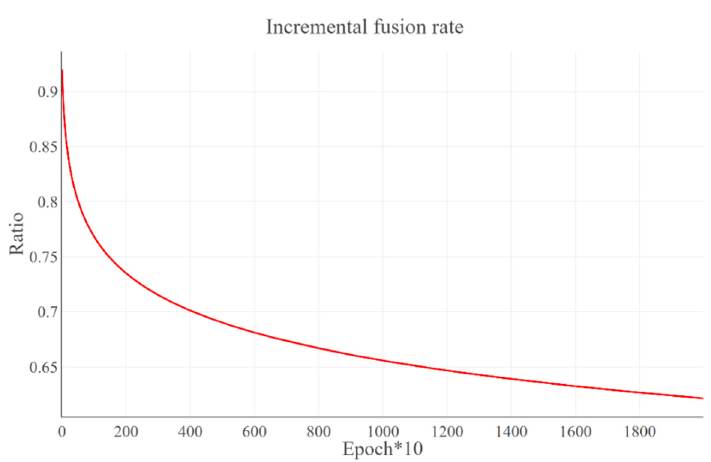
Figure 3. The curve of the incremental fusion rate. With the training progress, the ratio of 𝑥 to 𝑥(cid:3548) decreases.